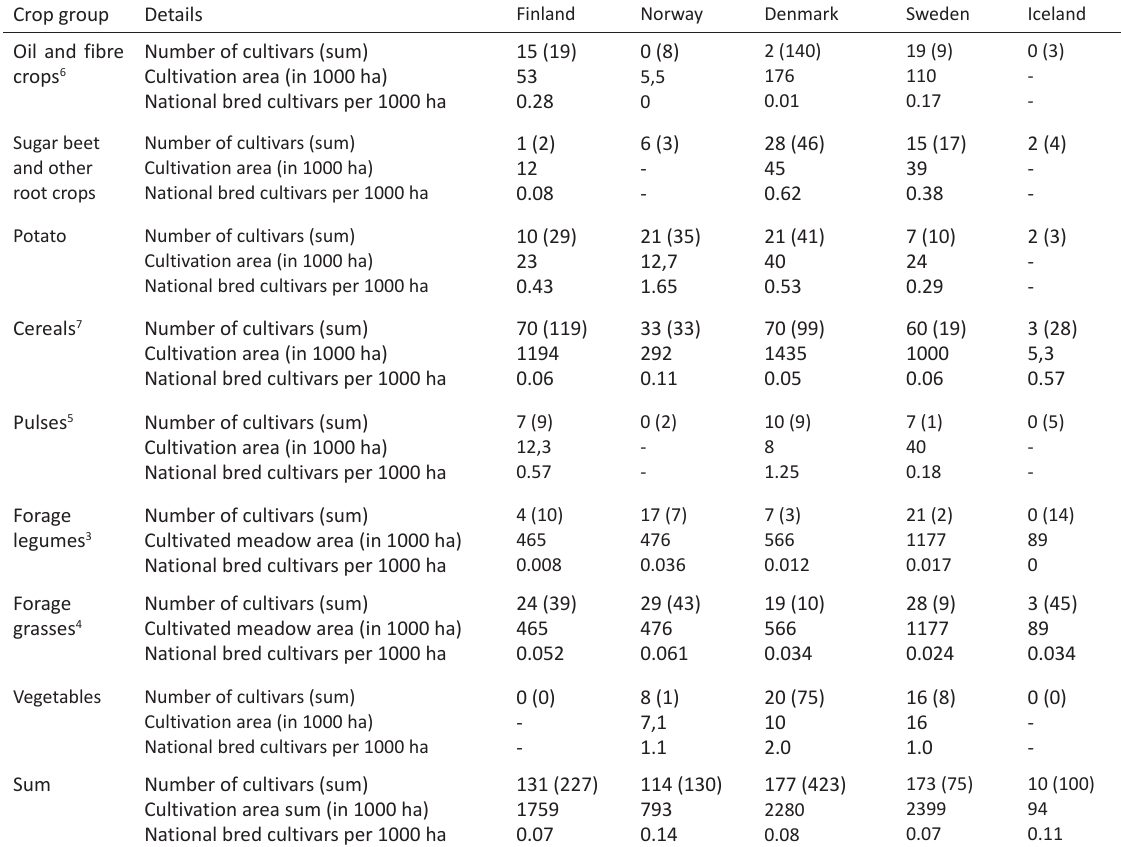
1 For all countries: fruit and berries, turf grass and energy crops not included. Conservation varieties are not included. 2 Root crops for Finland and Sweden include sugar beet and swede, for Norway fodder beet, forage rape ( Brassica napus ), swede and turnips ( Brassica